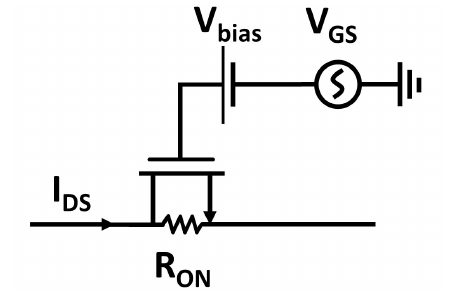
Figure 4. Circuit schematic of an NMOS transistor with a superposed dc bias